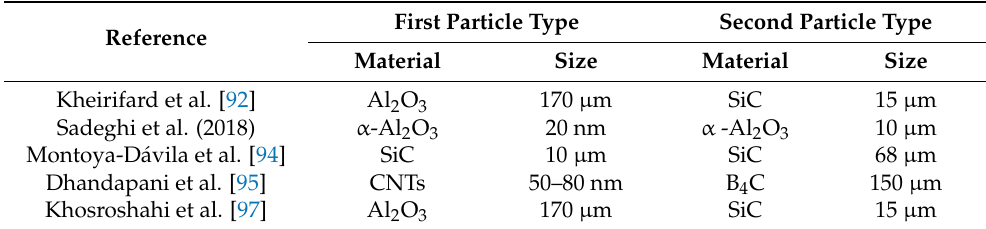
Table 5. Dual-particle-size combinations used in different